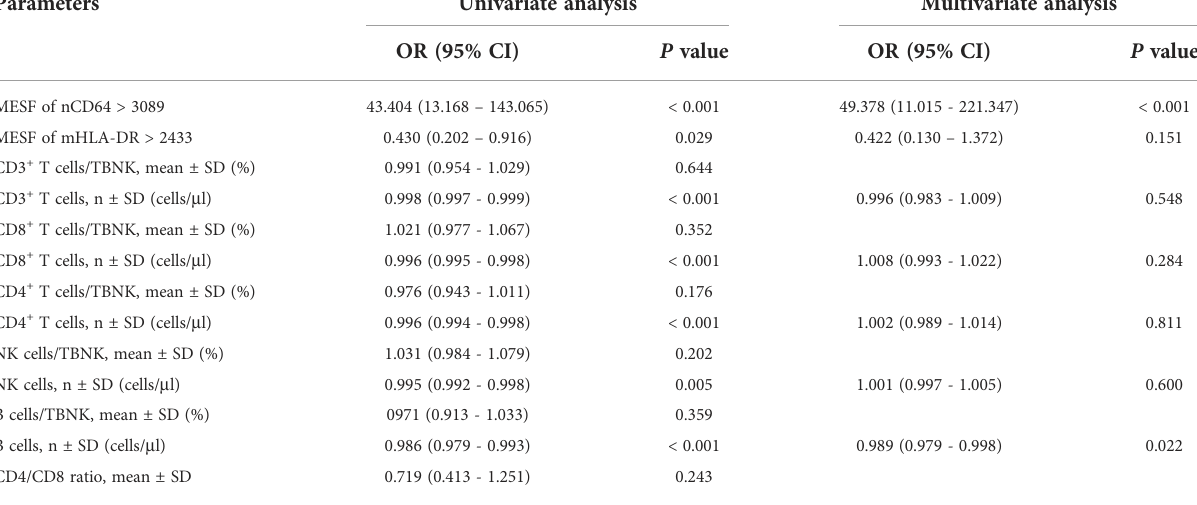
TABLE 6 Univariate and multivariate odds ratios for infection diagnosis among KTRs. Parameters Univariate analysis Multivariate